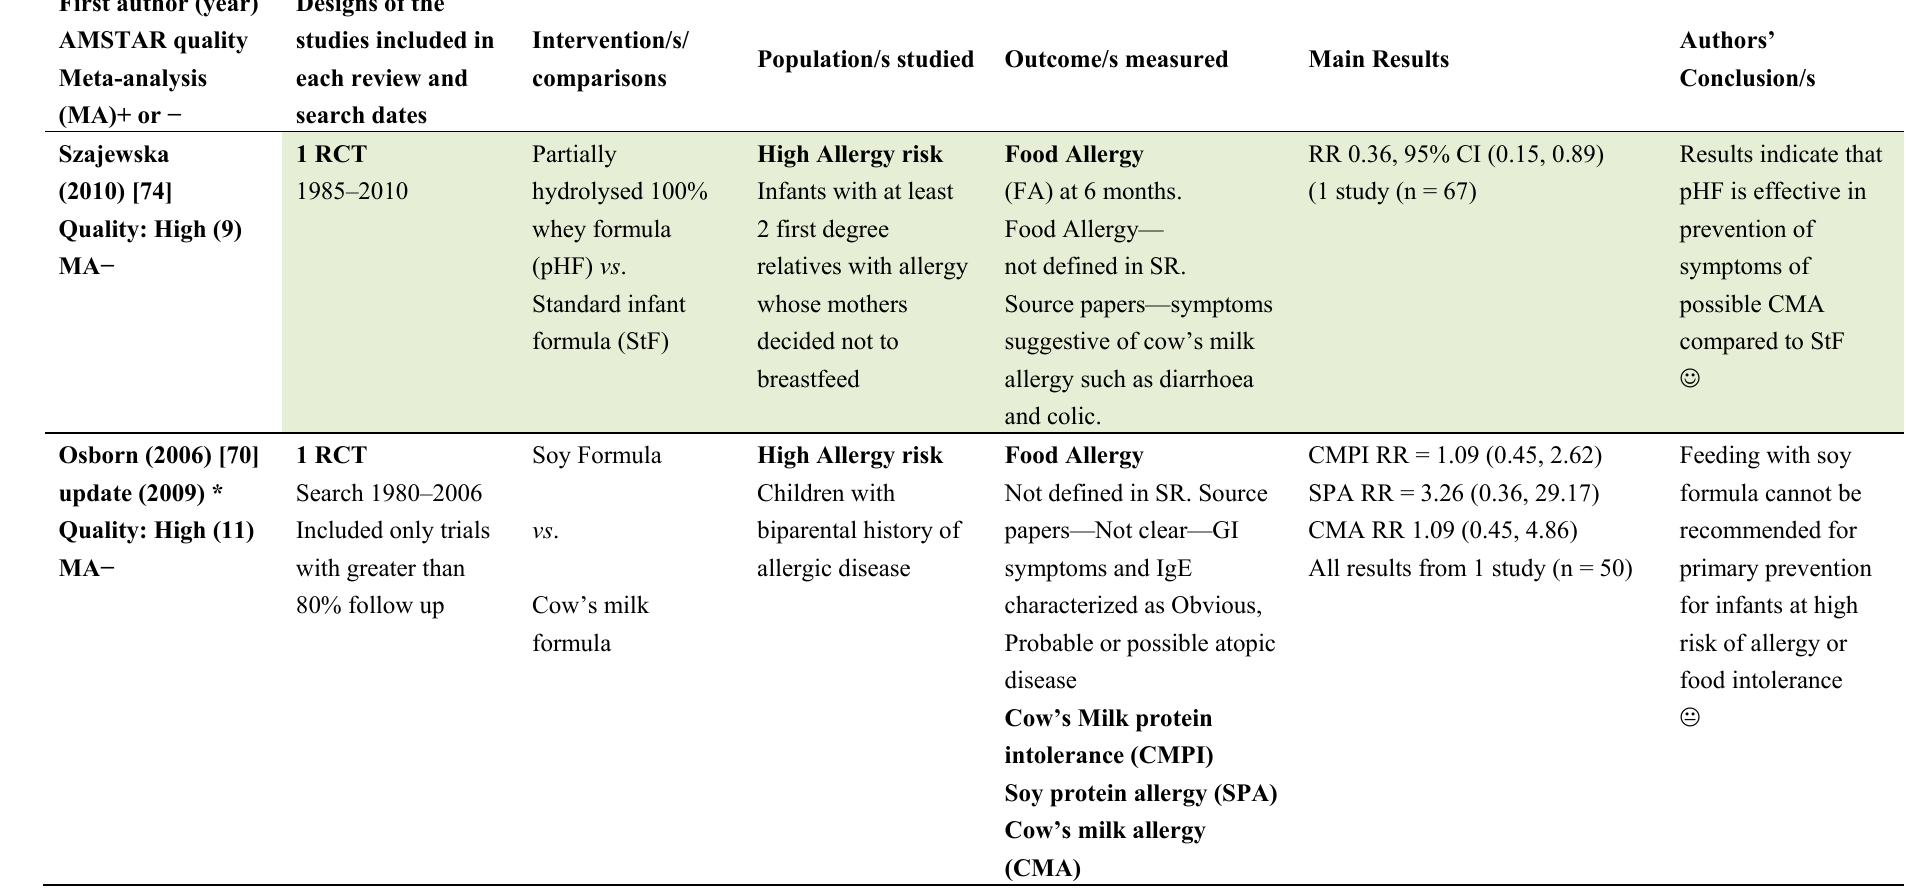
Table 1. Systematic reviews of Infant formulas and the risk of food allergy or food